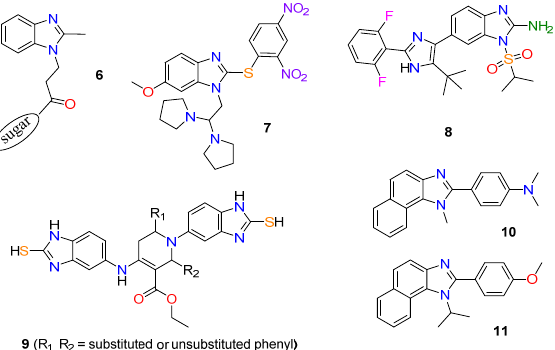
Figure 6. Selected examples of disubstituted and fused-ring benzimidazole analogs bearing anti- inflammatory properties.